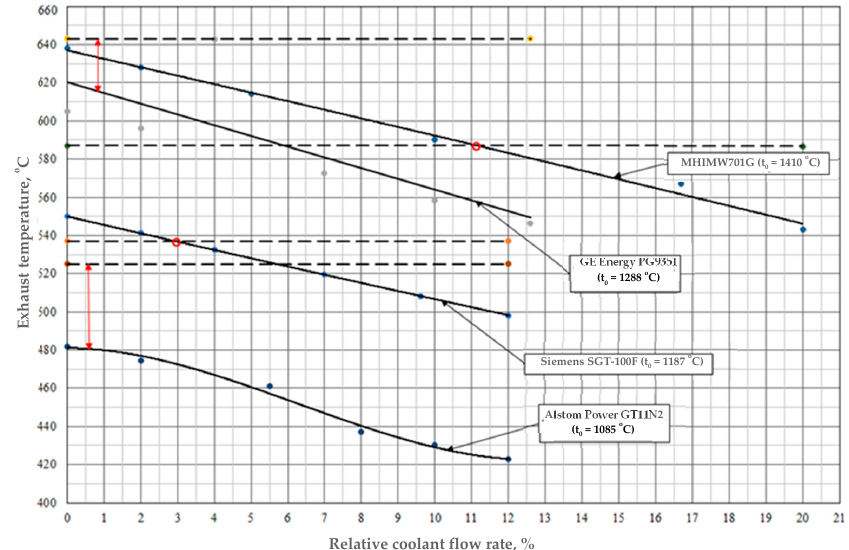
Figure 5. Dependences of temperature changes in exhaust gases of GTU with different levels of power and temperatures on the relative flow rate of the coolant. 217